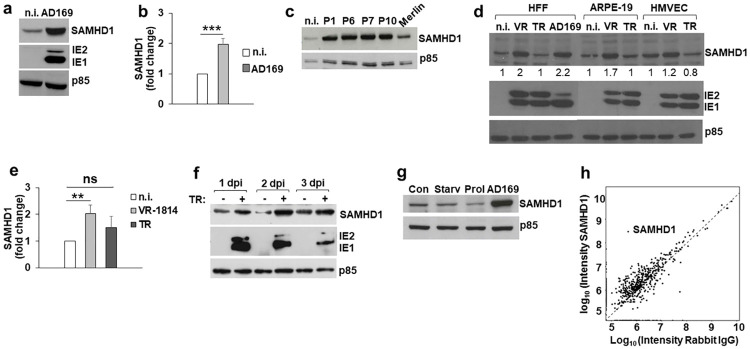
SAMHD1 protein expression in HCMV-infected cells.a) SAMHD1 levels were analyzed by immunoblotting in cell lysates of HFFs not infected (n.i.) or infected with AD169 at an MOI of 1 for 3 days. Expression of IE1/IE2 viral antigens was used as control for infection, while the p85 subunit of PI3K was used as loading control. A representative experiment out of six is shown. b) The relative amount of SAMHD1 protein, normalized to that of p85, was determined by densitometric analysis and is relative to that of n.i. cells, which was arbitrarily set as 1. Data are expressed as mean ± SE of eight independent experiments. c) SAMHD1 expression in HFFs not infected (n.i.) or infected with HCMV clinical isolates collected from infants affected by congenital HCMV infection (P1, P6, P7 and P10), or with Merlin. Data derive from one representative experiment out of two. d) SAMHD1 expression in HFFs, ARPE-19 and HMVEC cells infected with the indicated HCMV strains. Data derive from one representative experiment out of two, performed at the same time with all conditions. Numbers indicate the relative amount of SAMHD1 protein, determined as in panel b). e) The relative amount of SAMHD1 protein from HFFs infected with the indicated clinical strains was determined as in panel b). Data are expressed as mean ± SE of eight independent experiments. All data derive from cells infected at an MOI of 1 and harvested at 3 dpi. f) PMA-differentiated THP-1 cells not infected or infected with TR at an MOI of 1 for the indicated times. Expression of SAMHD1, viral antigens and p85 was evaluated as above. A representative experiment out of two is shown. g) SAMHD1 expression in HFFs induced to reach confluence (Con), serum-starved (Starv), proliferating (Prol), or infected with AD169 at an MOI of 1 for 3 days. Data derive from one representative experiment out of two. h) Antibody validation of the anti-SAMHD1 antibody by immunocapture MS. Proteins enriched by the antibody towards SAMHD1 (y-axis) are plotted versus non-specific enrichment by one Rabbit IgG pool (x-axis). Enriched proteins identified are quantified by label-free quantification and plotted as intensities (log10). **, p < 0.01; ***, p < 0.001; ns, not significant.